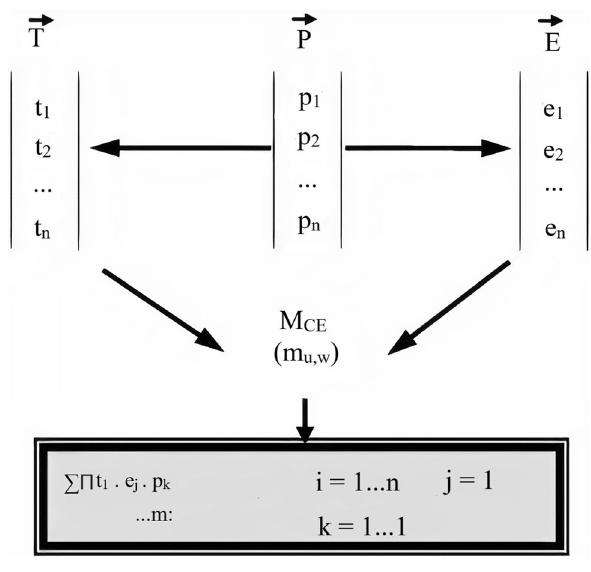
Fig. 21 Quantification of the OF of the modelling system